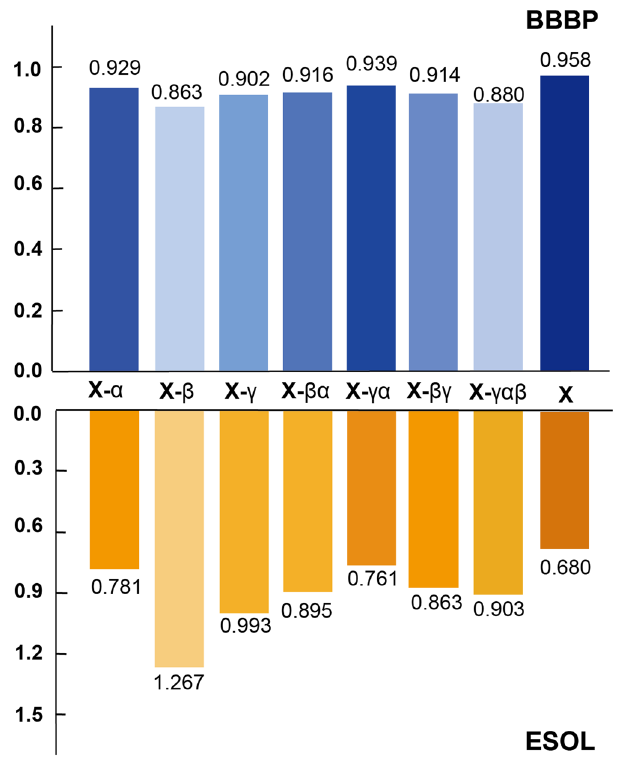
Fig. 3 Ablation results on BBBP and ESOL datasets. The “ X ” represent the PharmHGT, the “ X _ ” represents different PharmHGT variants of aggregating atom-level, junction-level, and pharm-level